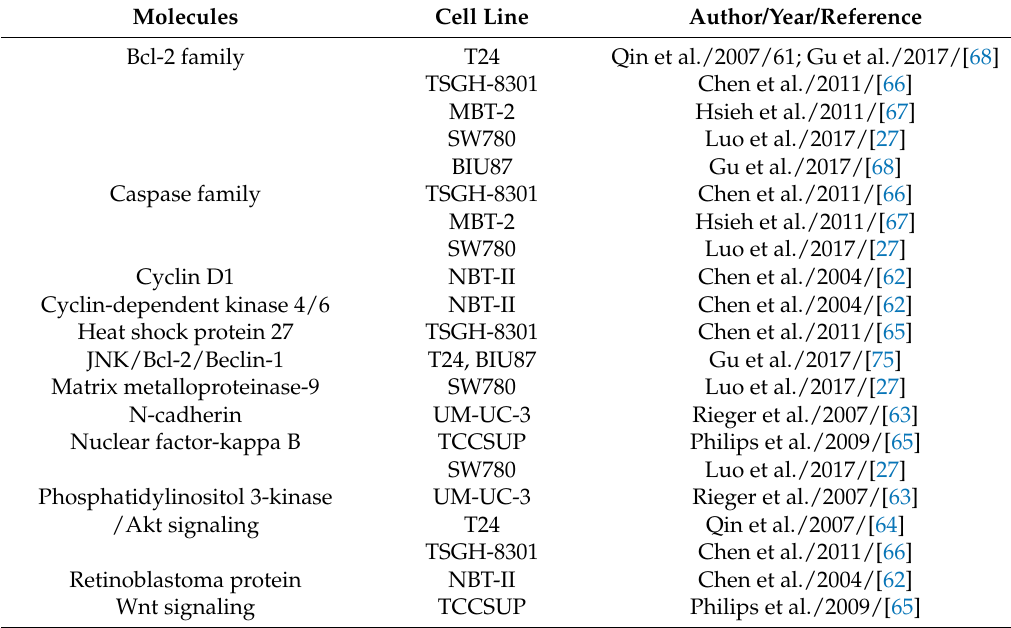
Table 4. Potential molecular targets of green tea polyphenols in bladder cancer cell